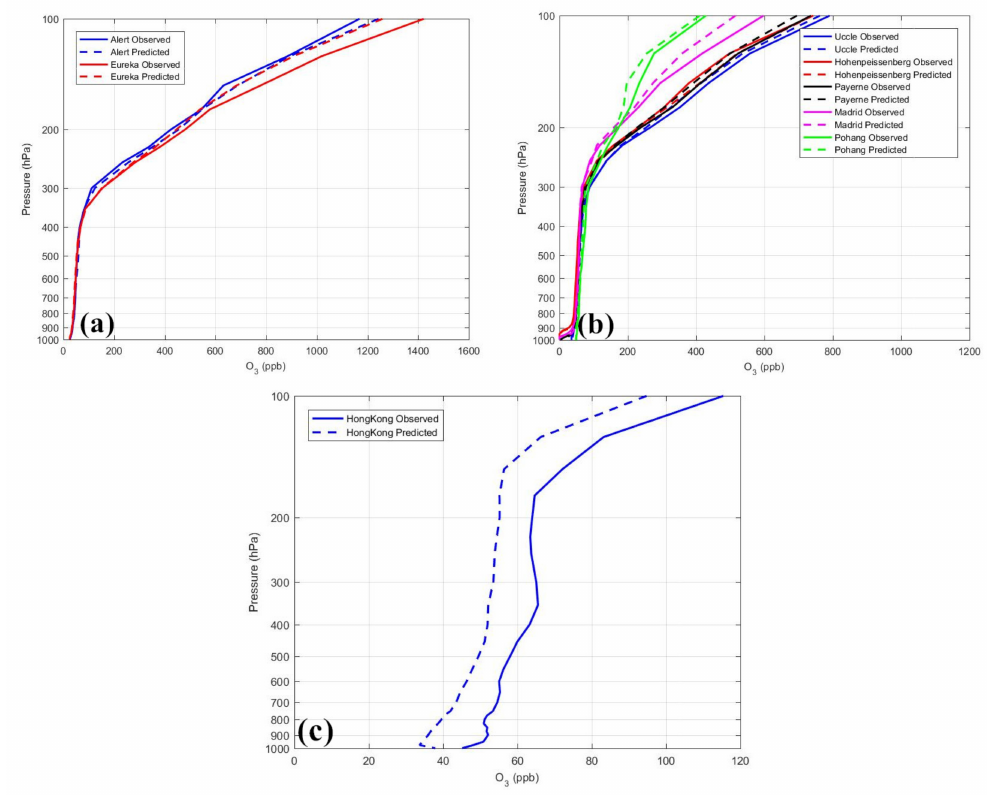
Figure 7. The mean vertical distribution of LST ozone on the test sets at WOUDC stations since 2019 for ( a ) NH, ( b ) NM, and ( c )